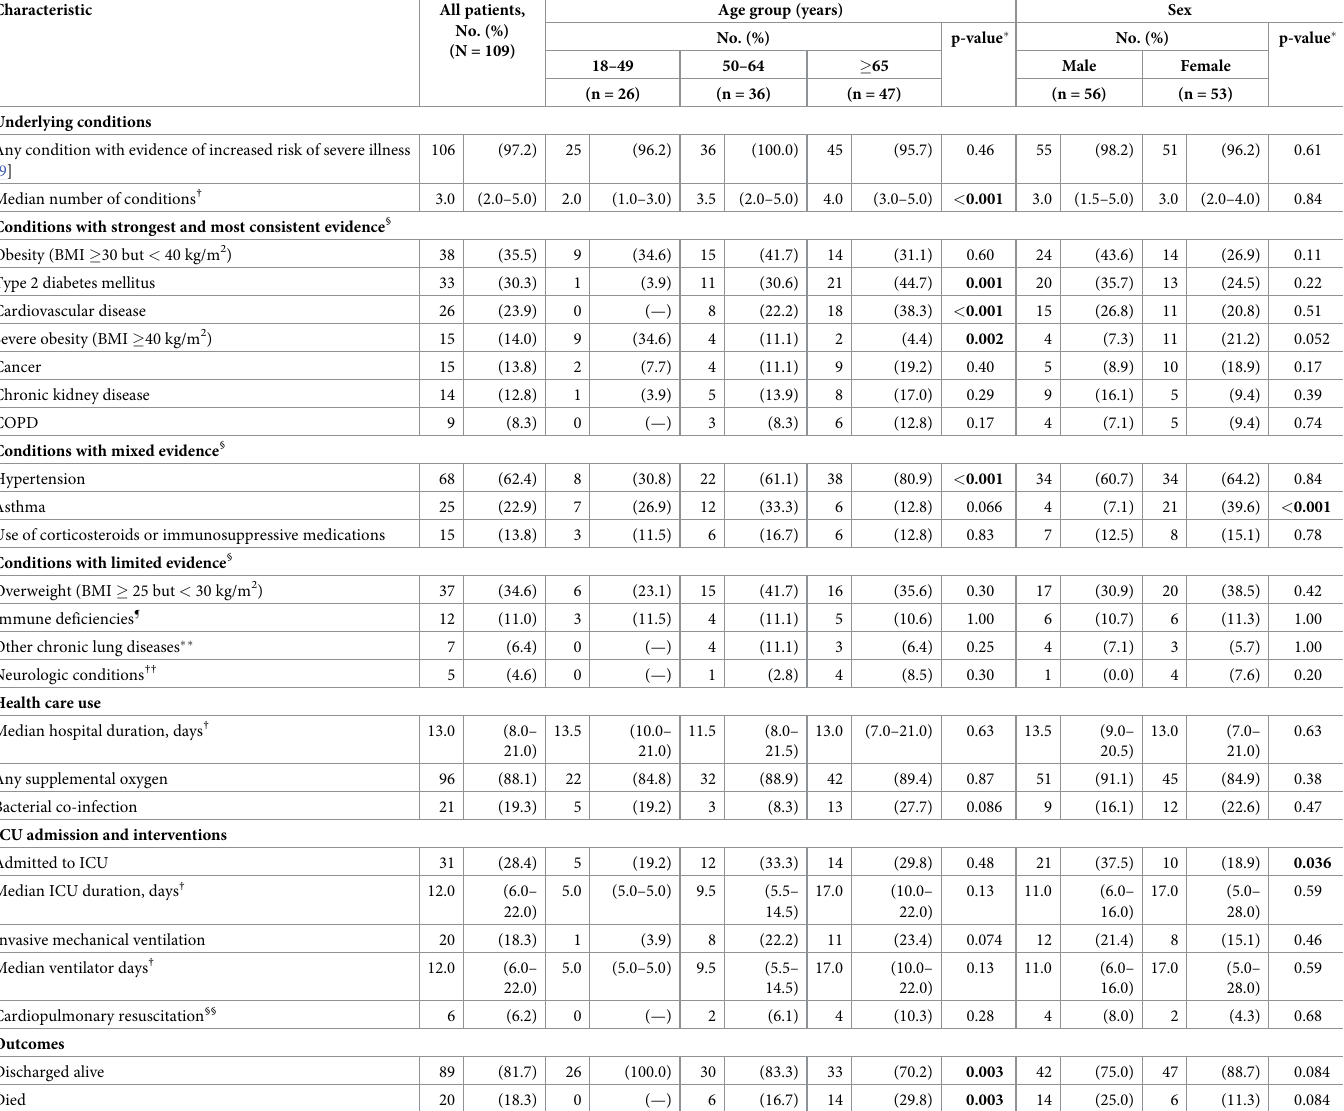
Table 2. Underlying medical conditions, health care use, interventions, and outcomes of adults hospitalized with COVID-19 (N = 109), by age group and sex— Puerto Rico, March-August